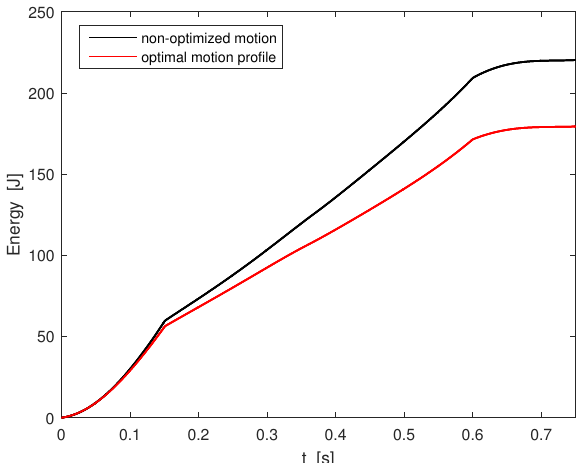
Figure 6. Absorbed electric power: non-optimized motion profile vs. optimized motion with trapezoidal pitch and yaw tool angles.